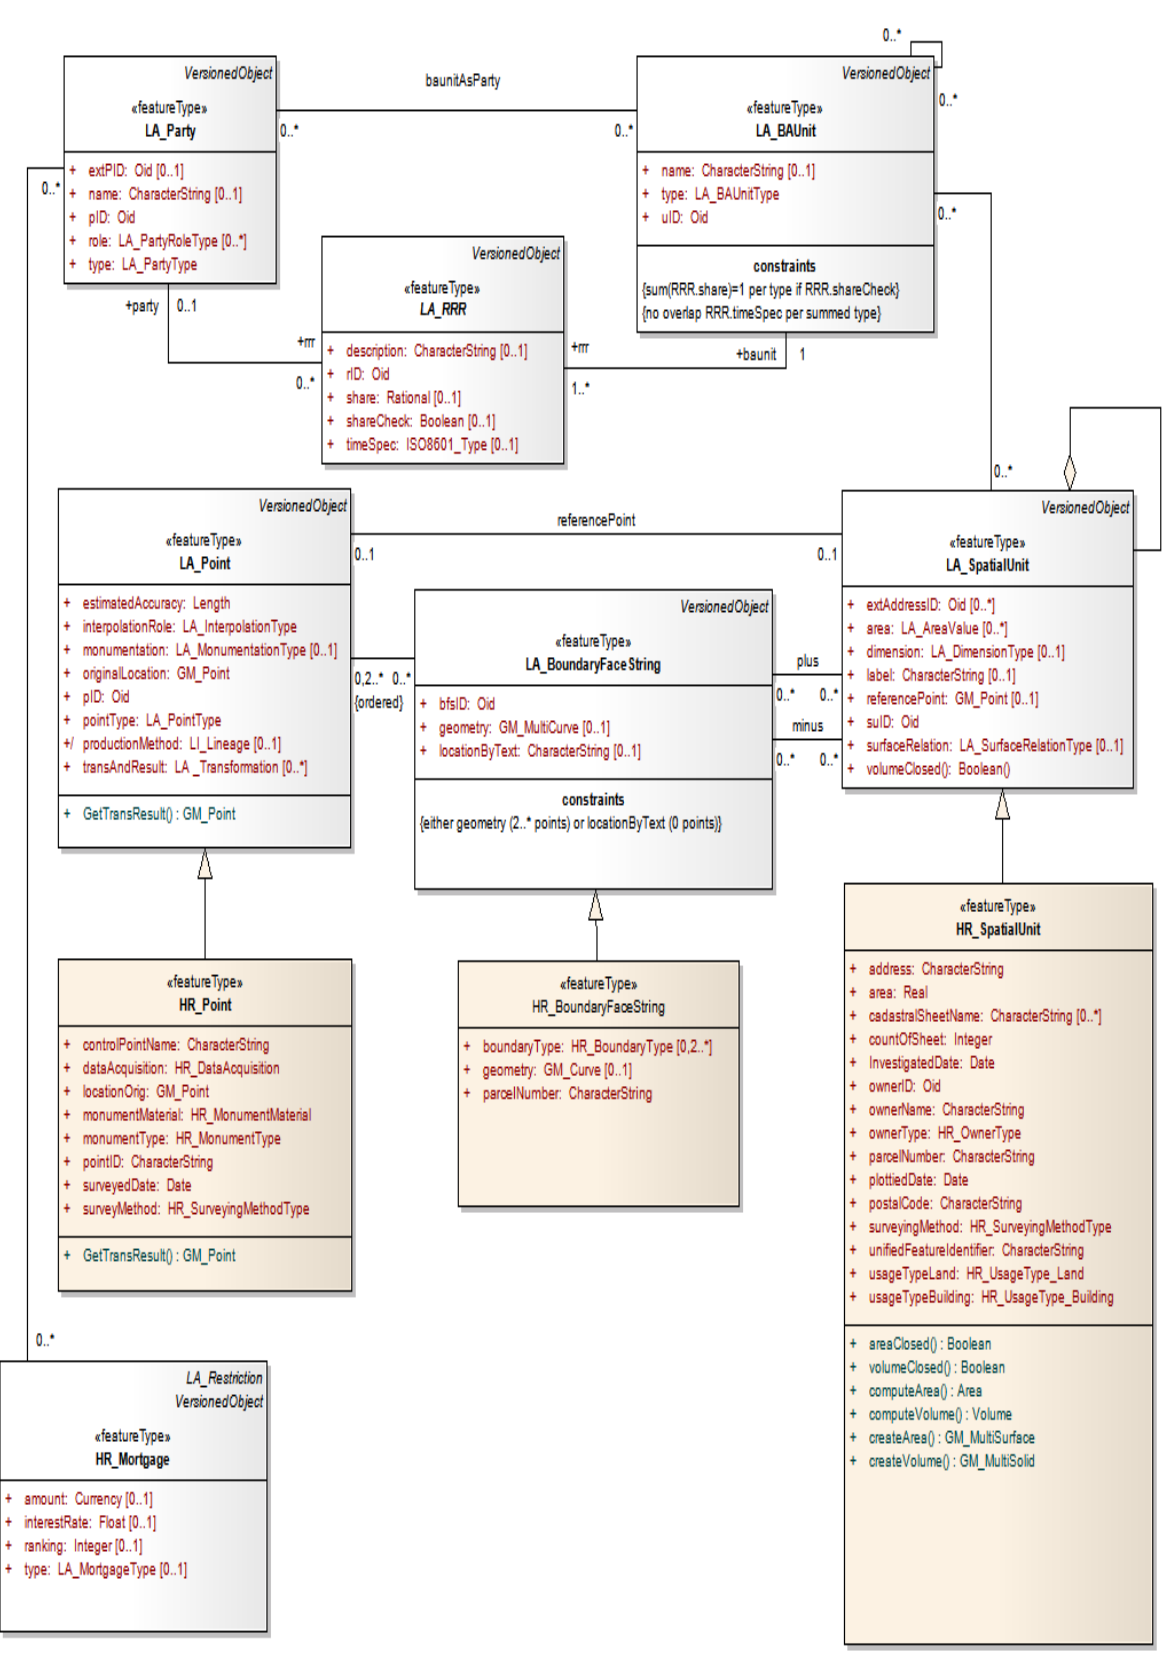
Figure 9. LADM profile